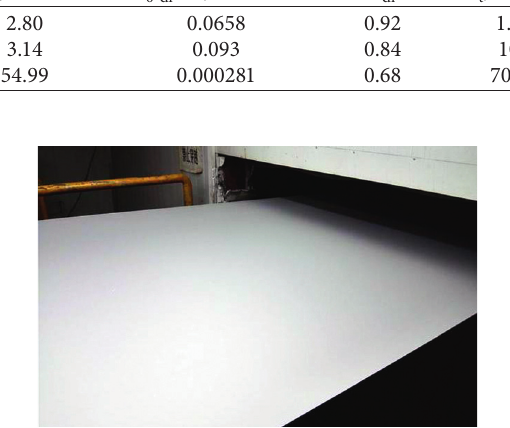
Figure 14: Optical surface of the 2205 DSS hot-rolled strip after industrial pickling with optimized pickling